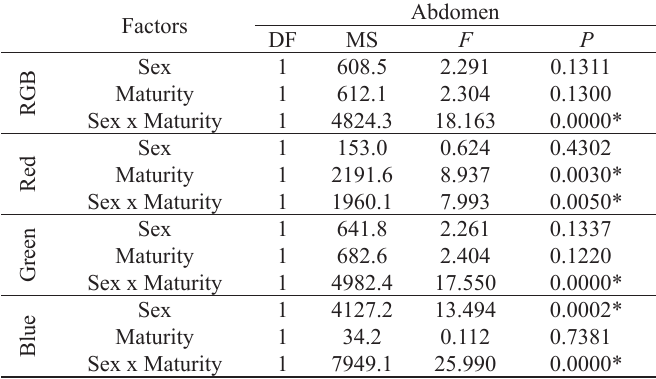
Comparison of the abdomen with the color spectra (RGB, red, green and blue) by two-way ANOVA; the first factor is the sex and the second is sexual maturity. DF = degrees of freedom, MS